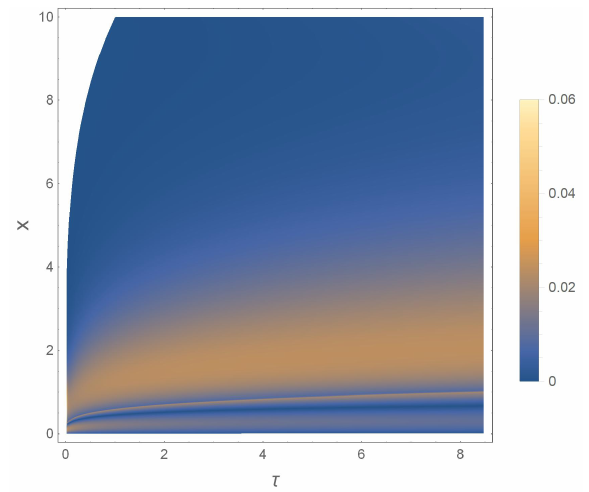
Figure 13. Absolute error for α = 0.5, λ 1 = 1, λ 2 = 2, κ 1 = 1, κ 2 = 1.